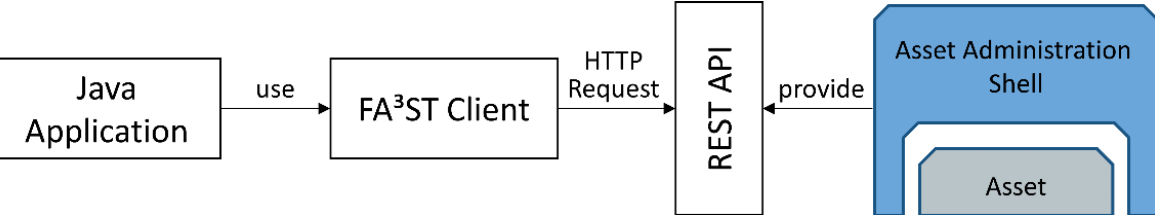
Figure 10. FA 3 ST HTTP Client.